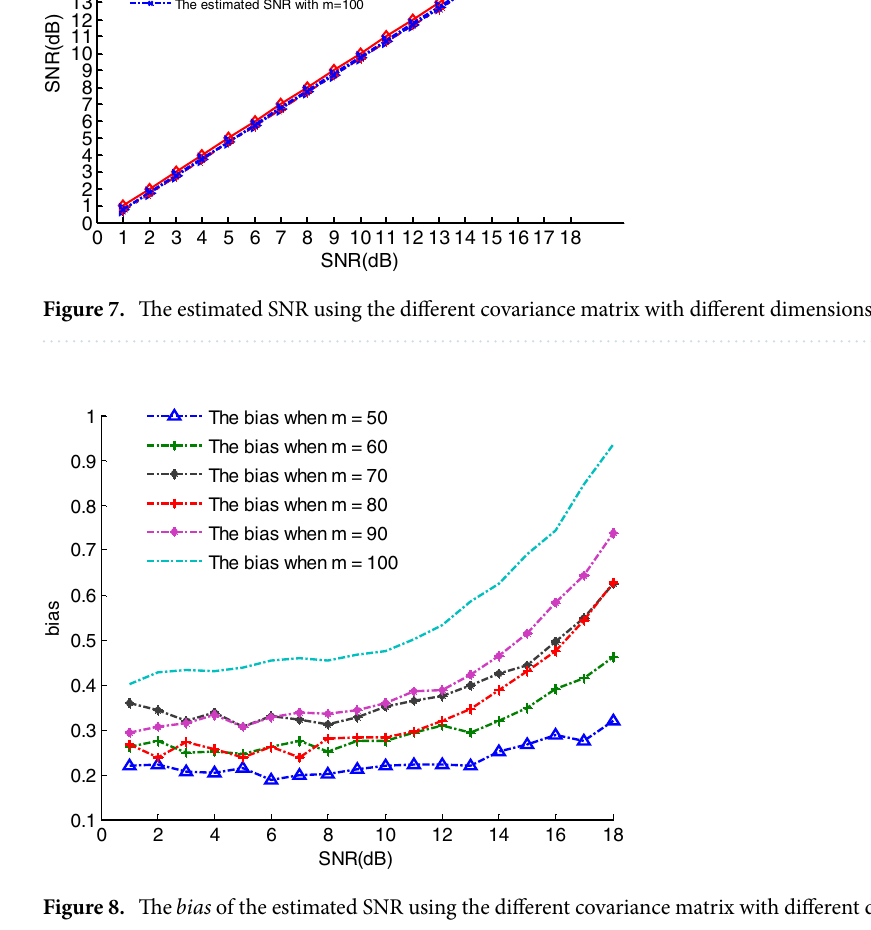
Figure 8. The bias of the estimated SNR using the different covariance matrix with different